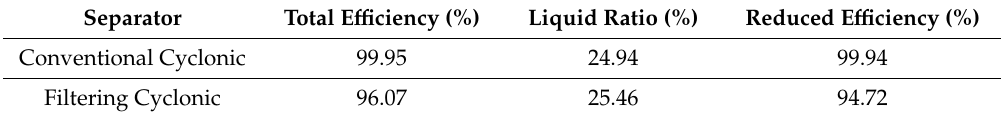
Table 6. The separation e ffi ciency of oil and the liquid ratio of the